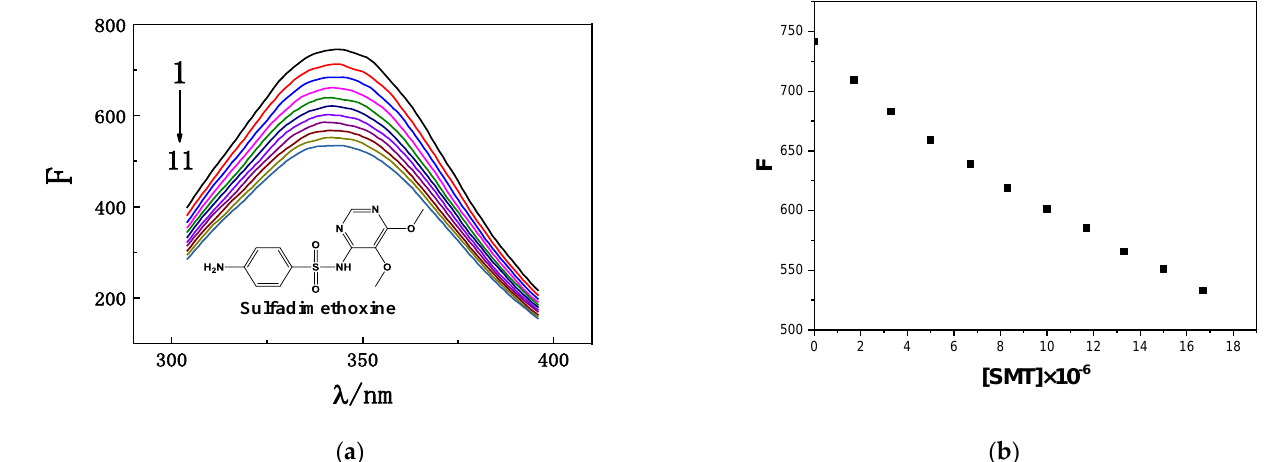
Figure 1. ( a ) Fluorescence emission spectra of HSA with different SMT concentrations. C HSA = 1.7 × 10 −6 mol·L −1 ; C SMT (1–11) = 0, 1.7, 3.3, 5.0, 6.7, 8.3, 10.0, 11.7, 13.3, 15.0, 16.7 × 10 −6 mol·L −1 . ( b ) Fluorescence intensity corresponding to different SMT concentrations.